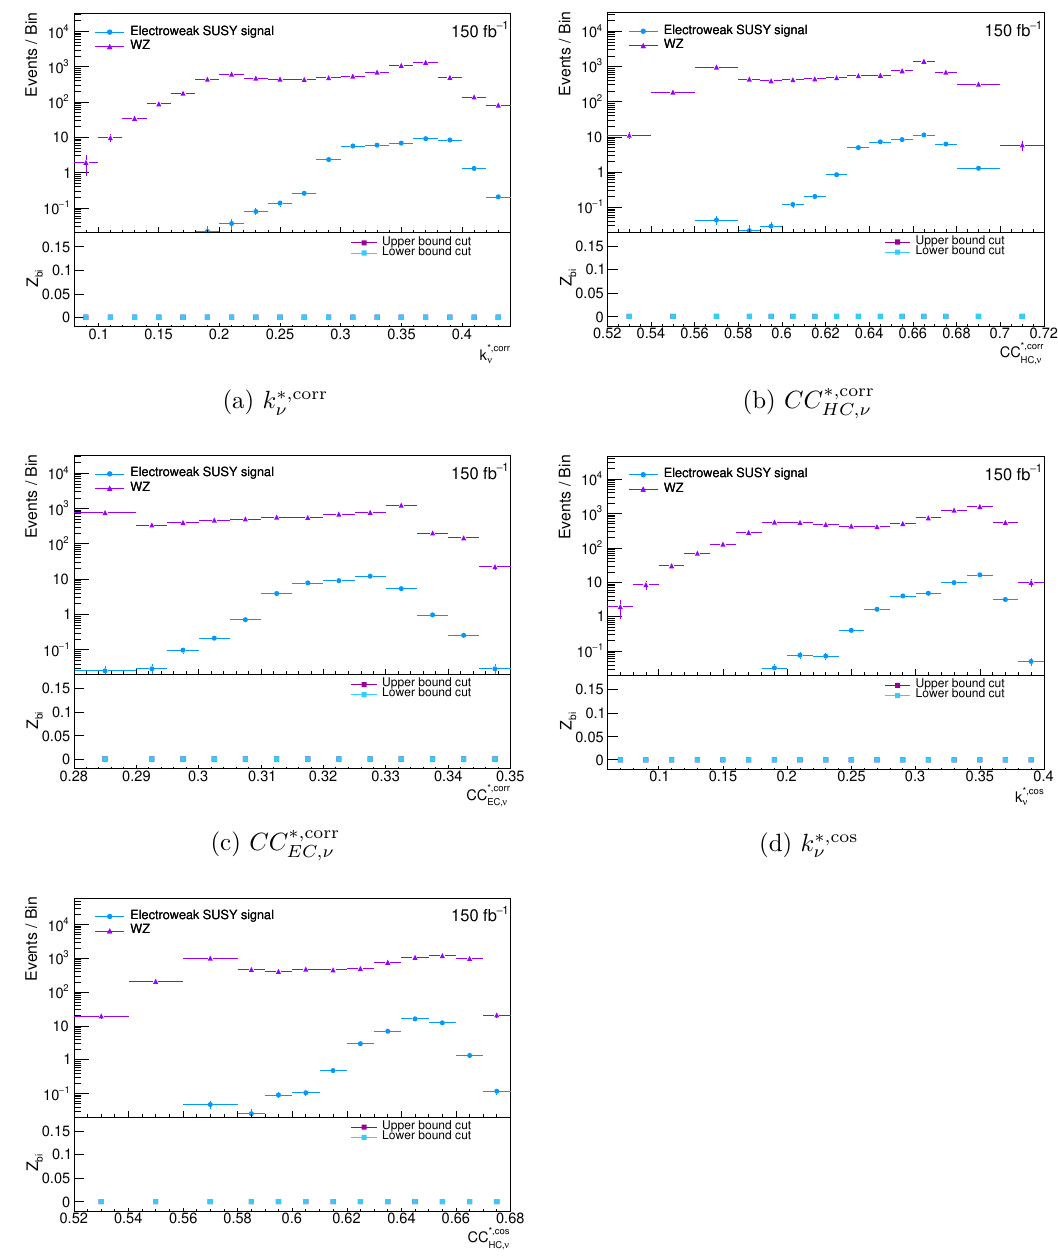
Figure 5. Event rates as a function of useful network metrics for our prototype electroweakino analysis calculated using d corr and d cos . Events in the overflow bin are not shown in the distribution but are included in the Z bi